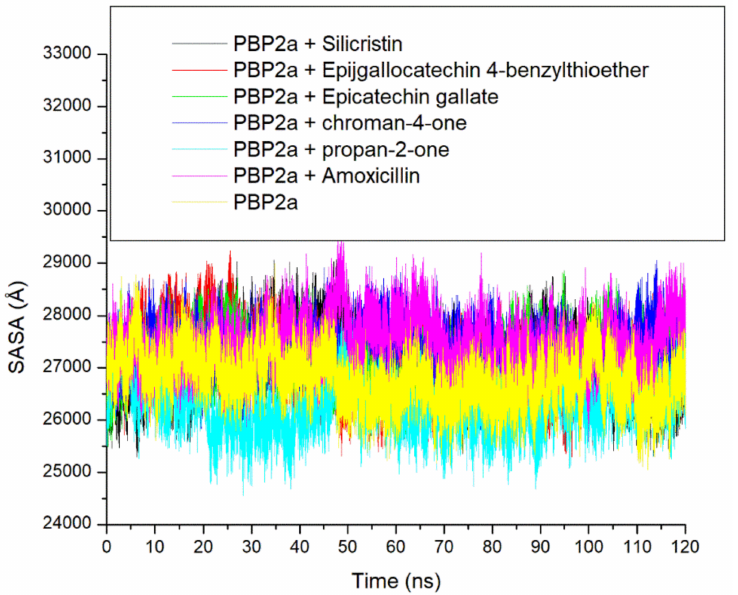
Figure 7. Comparative solvent-accessible surface area (SASA) plots of alpha-carbon, the top-five phenolics, and amoxicillin against the active site of PBP2a of S. aureus over a 120 ns MD simulation